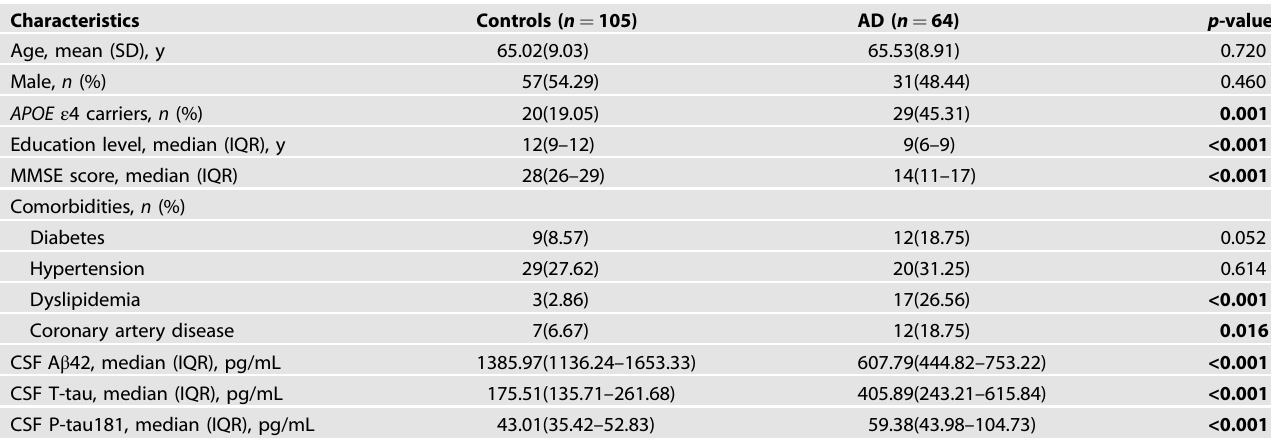
Table 1. Characteristics of the